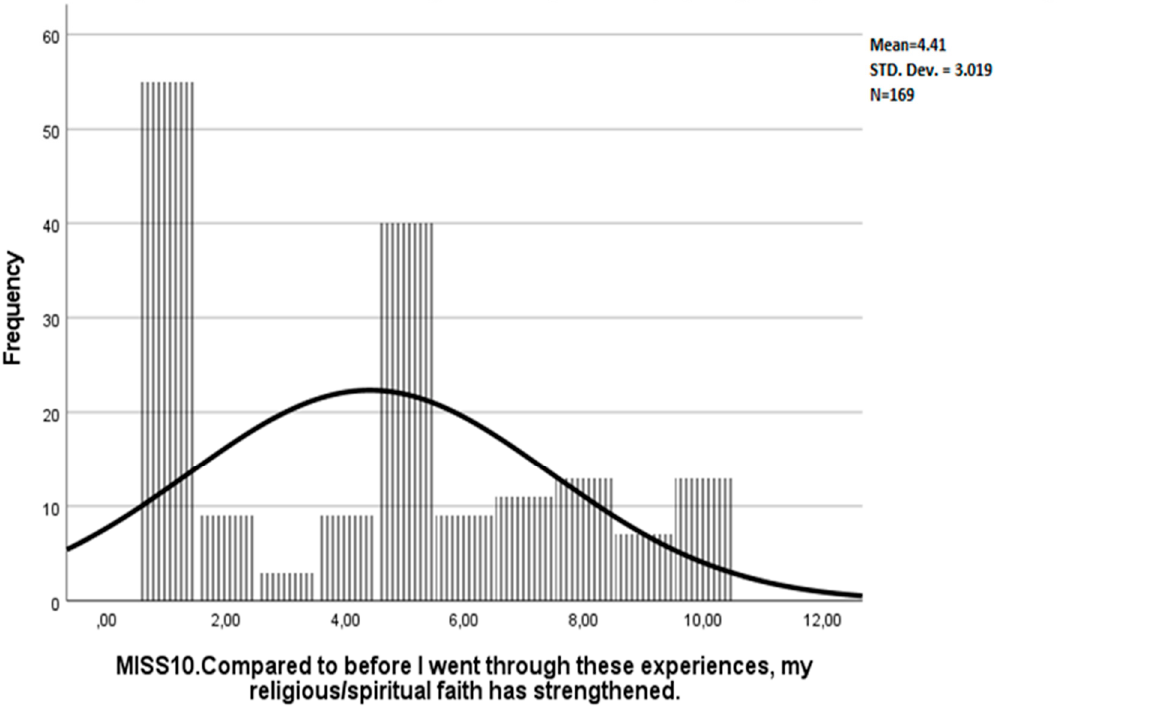
Figure 6. Frequency distribution of MISS10 in the original study by Mantri et al., when the participants who omitted the item after they had read it, were assigned a value of 1 [19].